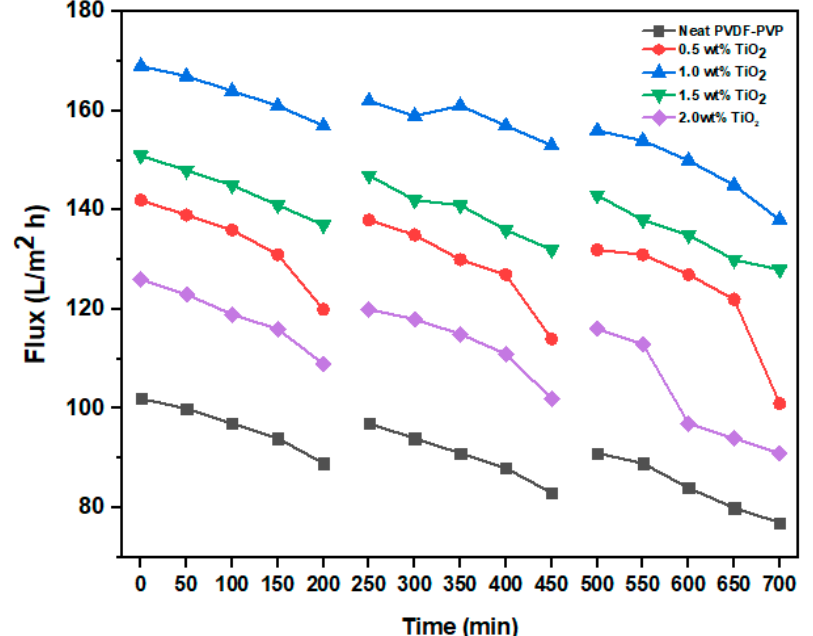
Figure 9. Antifouling and recycling properties of hollow fiber membranes as a function of time.